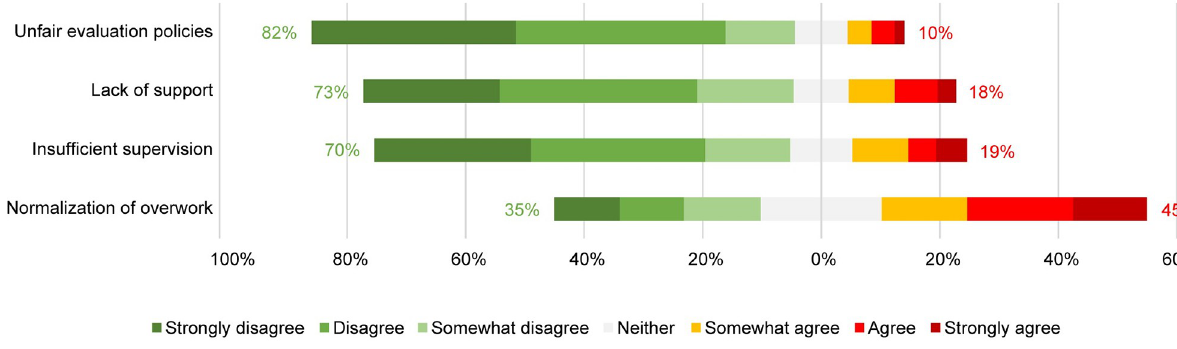
Fig 2. Barriers to a responsible research climate experienced in the scientific